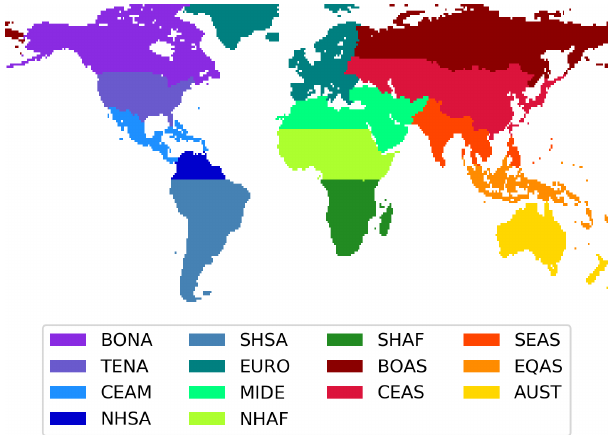
Figure 2. Geographical regions defined in GFED, adapted from http://www.globalfiredata.org/data.html (last access: 22 March